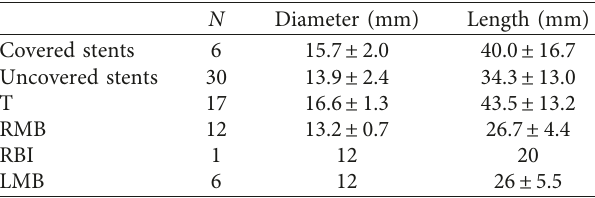
COPD: chronic obstructive pulmonary disease; CHD: coronary heart disease; SCLC: small cell lung carcinoma; Chemo: chemotherapy; RT: radiotherapy; TKI: tyrosine kinase inhibitor; BST: best support therapy; RMB � right main bronchus; LMB � left main bronchus; RBI � right bronchus intermedius; BST: best support therapy. Table 2: Characteristic details of stents ( n �